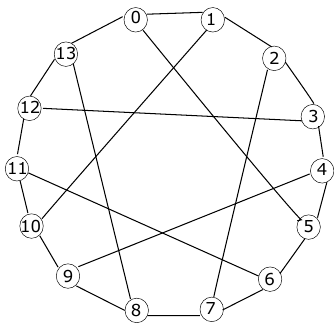
Figure 5. Node distribution of a Heawood